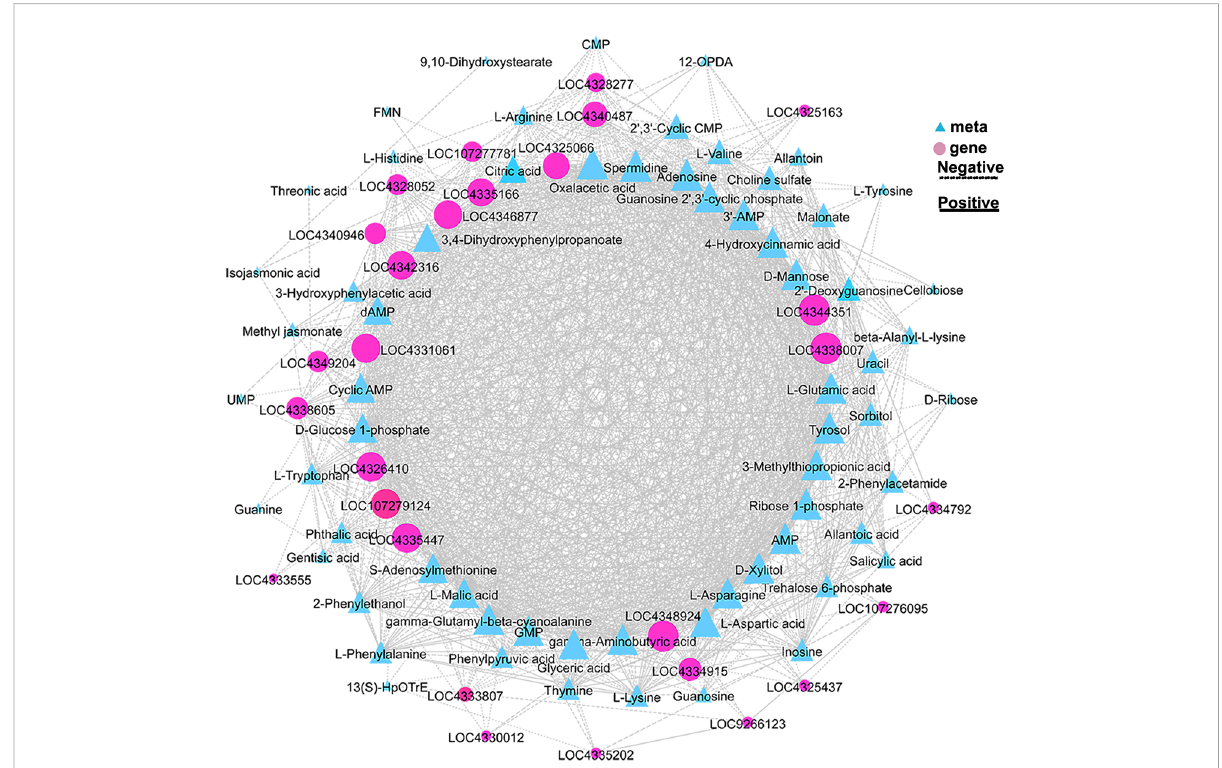
FIGURE 9 Correlation network map. Expression patterns of genes related to sugar, amino acid, nucleotide, glutathione, quinoline, and fl avone metabolism and hormone